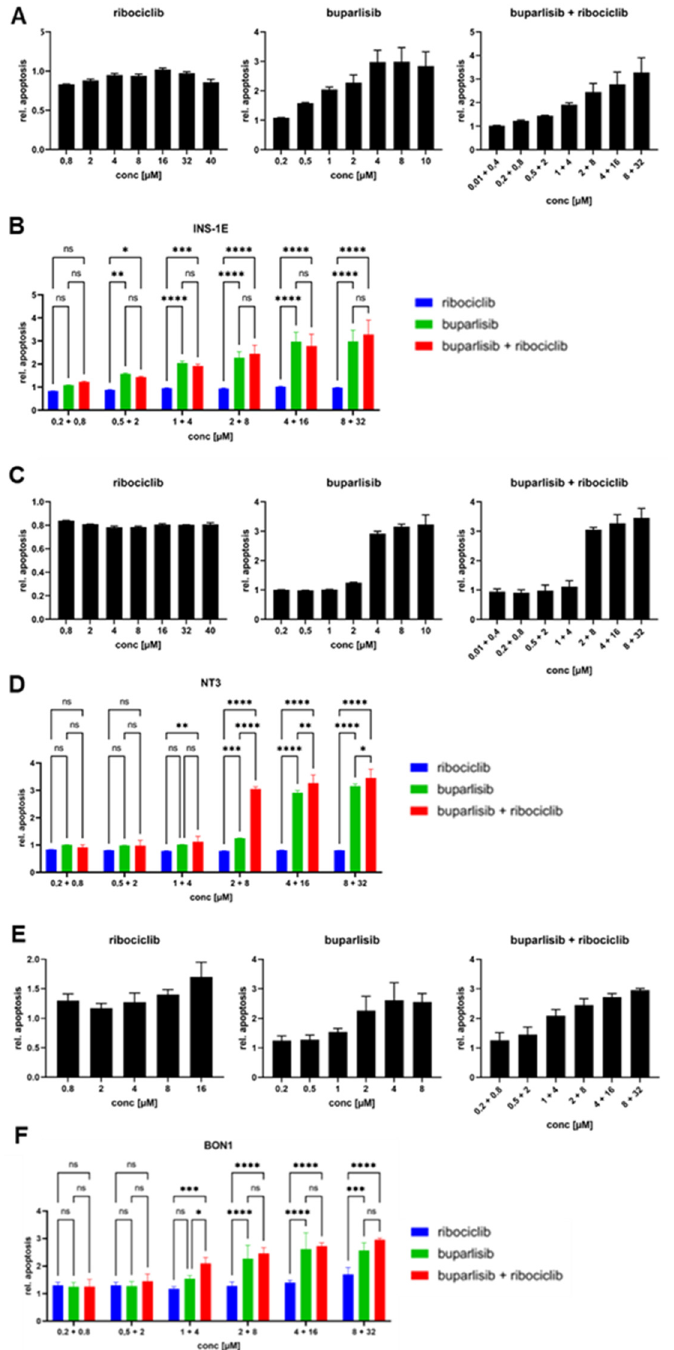
Figure 2. Apoptosis induction upon treatment of INS ‐ 1E, NT ‐ 3 and BON ‐ 1 cells as 2D cultures. INS ‐ 1E ( A , B ), NT ‐ 3 ( C , D ) and BON ‐ 1 ( E , F ) cells were treated with buparlisib, ribociclib, a combination of both drugs or DMSO vehicle control, and caspase 9 activity was measured after 72 h. ( A , C , E ) A range of concentrations was used to evaluate the effect of the drug treatments. ( B , D , F ) Comparison of the different treatment regimens. Data was normalized to the DMSO control; the mean ± SD from three independent experiments with three technical replicates each is shown. Two ‐ way ANOVA. ns, not significant; *, p < 0.05; **, p < 0.01; ***, p < 0.001; ****, p < 0.0001.